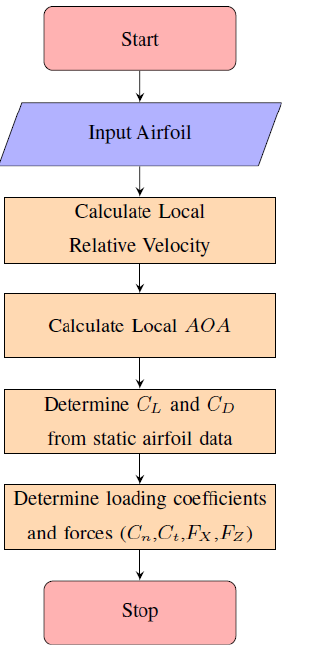
Figure 10. Flowchart of the parked load numerical model.